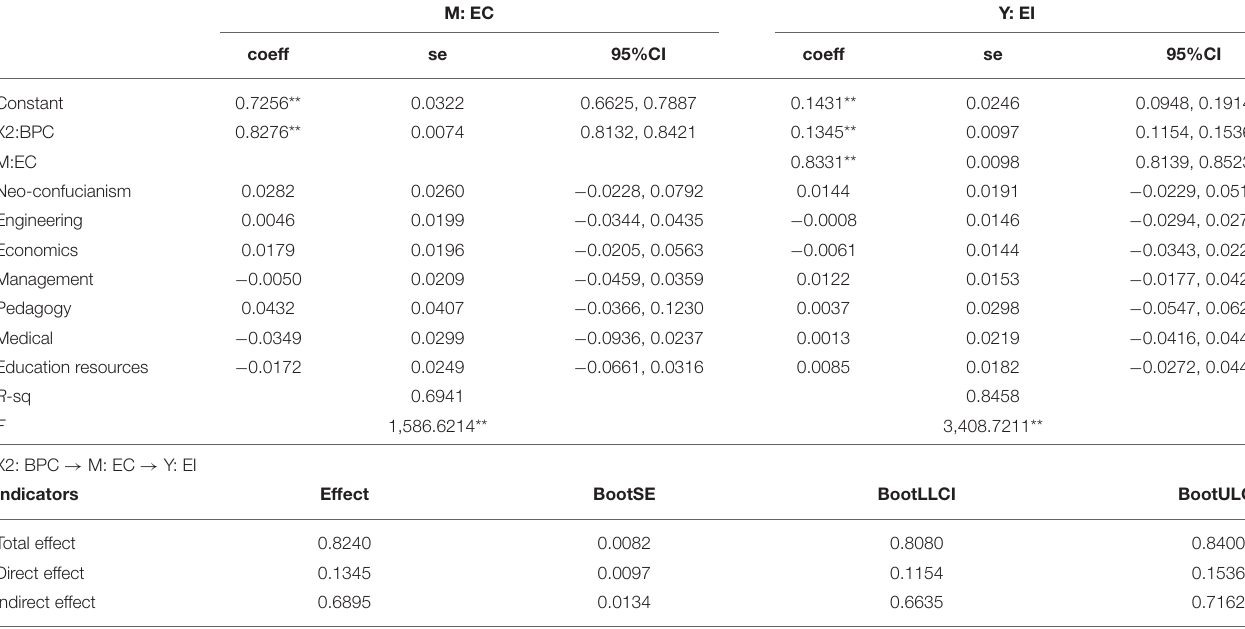
TABLE 5 | Moderated mediating effect analysis with BPC as independent